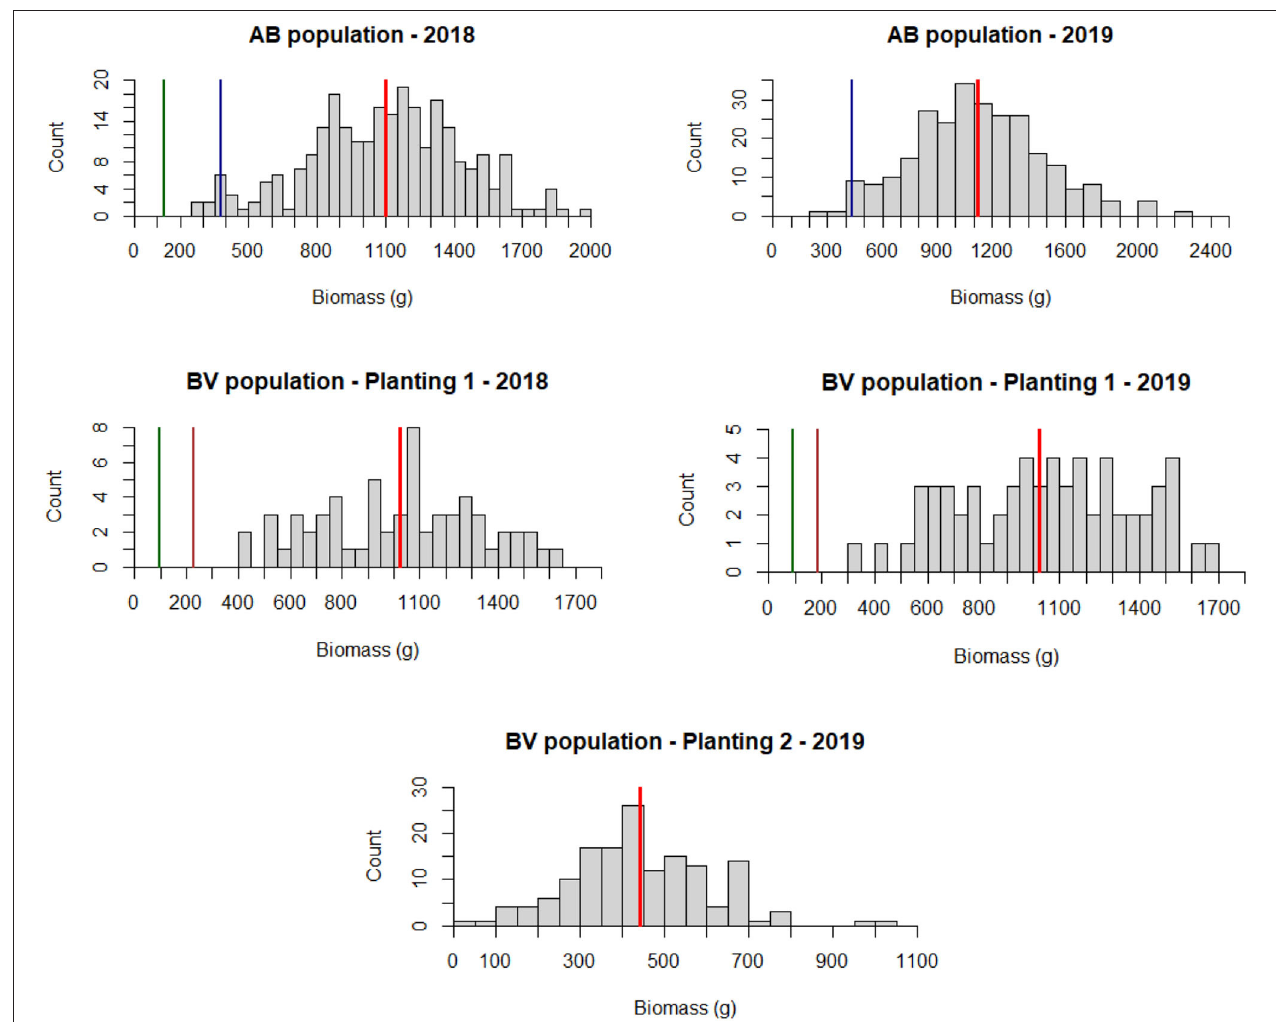
FIGURE 3 | Phenotypic trait distribution of dry biomass weight in grams for AB and BV populations for 2 years of field evaluation (2018 and 2019). The first set of the BV population was phenotyped for both years while the second set was phenotyped in 2019. Redline = population mean; Greenline = B6 parent, Blueline AP13 parent; Brown line = VS16 parent. B6 plant from the AB population was dead during the second year of planting. For the BV population, parent plants were only planted in the plot containing the first set of the